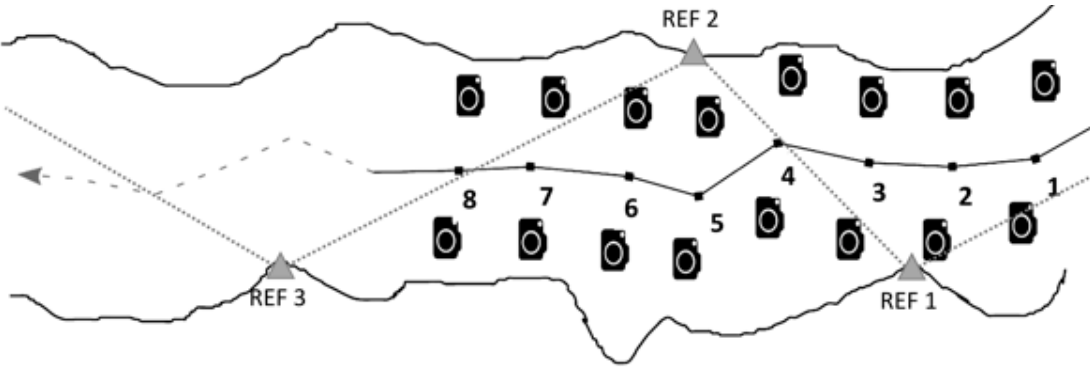
Figure 4. Scheme of the cave survey.